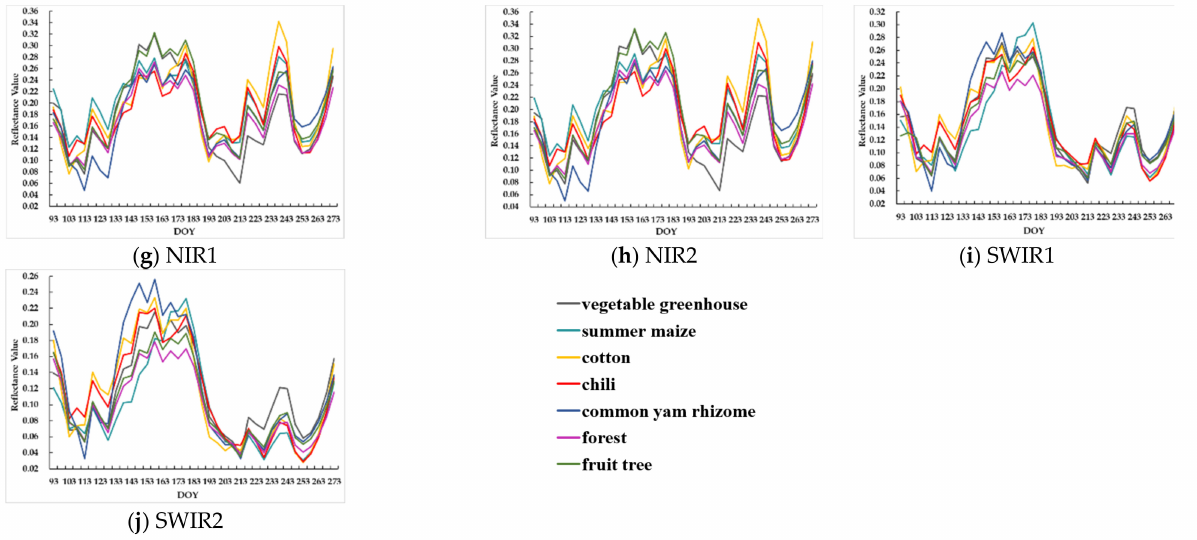
Figure 6. ( a – j ) Bottom-of-atmosphere reflectance profiles of each crop type from the filled Sentinel-2 time series data.